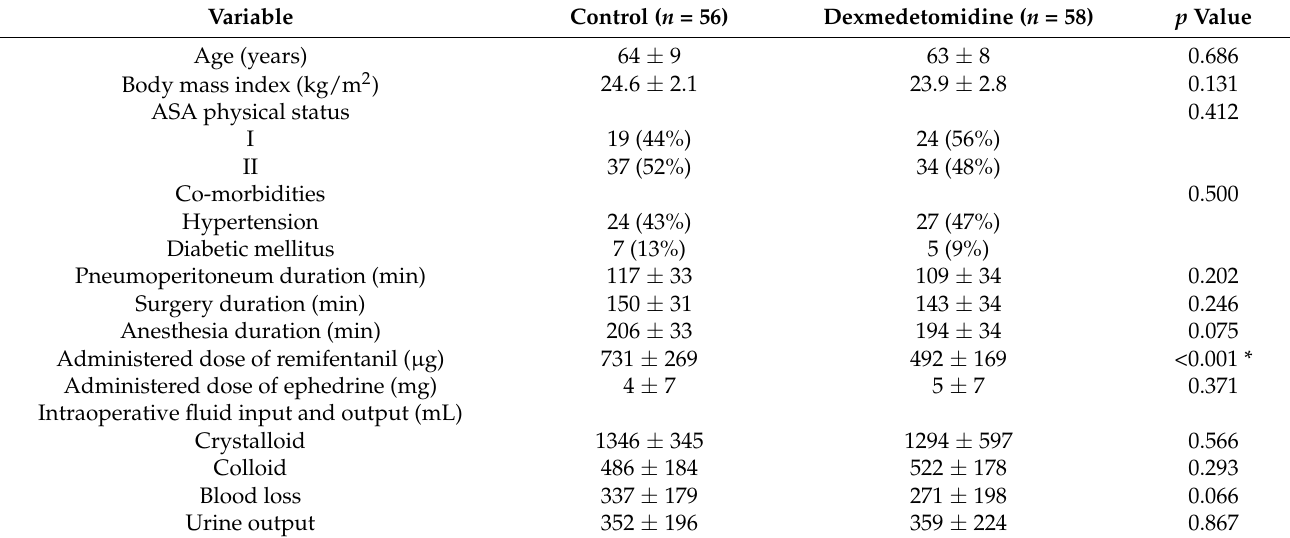
Table 1. Demographics and operative variables.